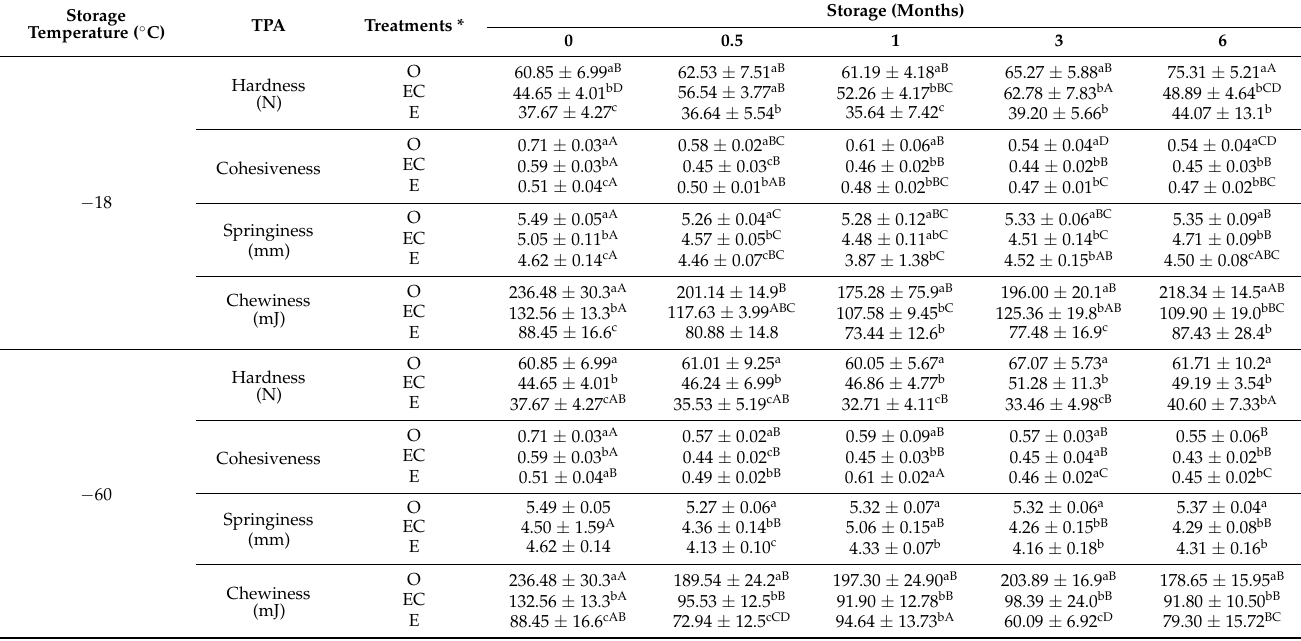
Table 6. Texture profile analysis of meat analogs with different fat replacers (O, EC, and E) during the freezing storage ( − 18 ◦ C, − 60 ◦ C) for six